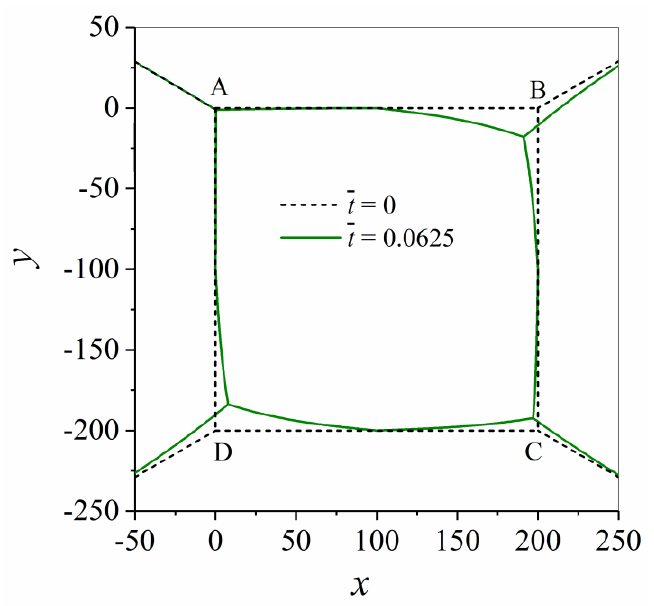
Figure 19. Shrinkage of an initially quadratic grain in arrangement B with different mobilities at the triple junctions A, B, C and D.